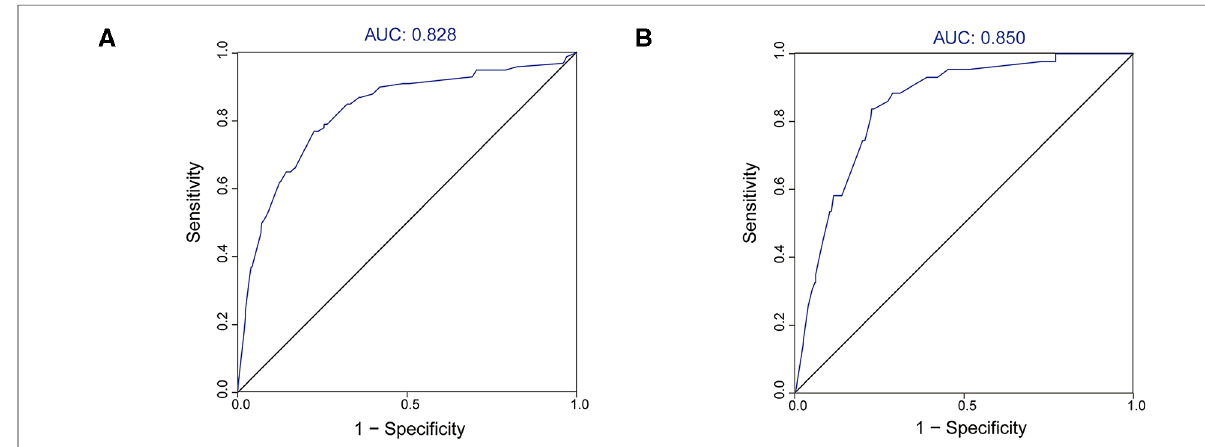
FIGURE 3 ROC curves and AUC values of the nomogram. ( A ) The training cohort; ( B ) the validation